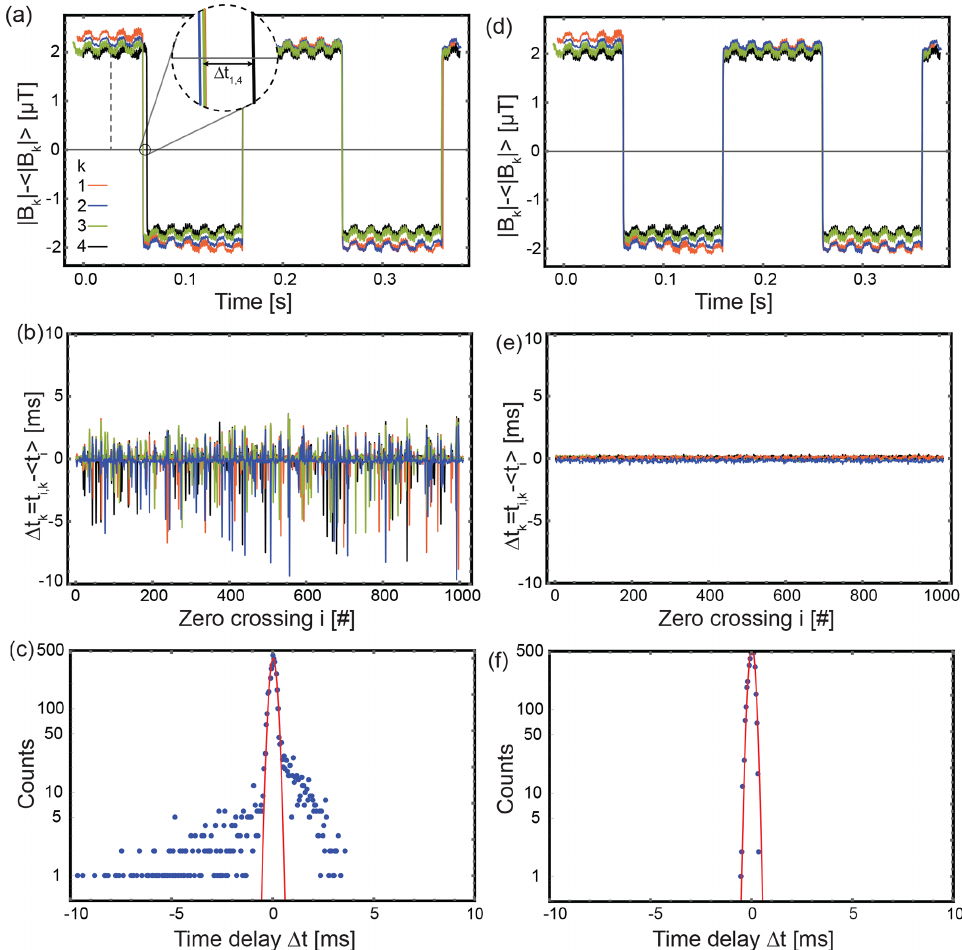
Figure 2. Characterization measurement of the time synchronization algorithm. The four magnetometers are subjected to a square-wave- modulated magnetic field. Panels (a–c) show measurements with unprocessed time tags. Panels (d–f) show the time tags after processing. (a) Time series of the four magnetometer traces. The inset shows a discrepancy in magnetometer 4 at the zero crossing. (b) The difference of the mean zero-crossing time of the square wave and the individual zero-crossing time for each magnetometer for 2min of data. (c) Histogram of the data in (b) , with the red curve representing the best-fit Gaussian. While most zero-crossing events have the correct timing within the 120µs standard deviation of the Gaussian fit, there are a significant number of outliers. Panels (d) , (e) , and (f) show the same data after implementing the time synchronization